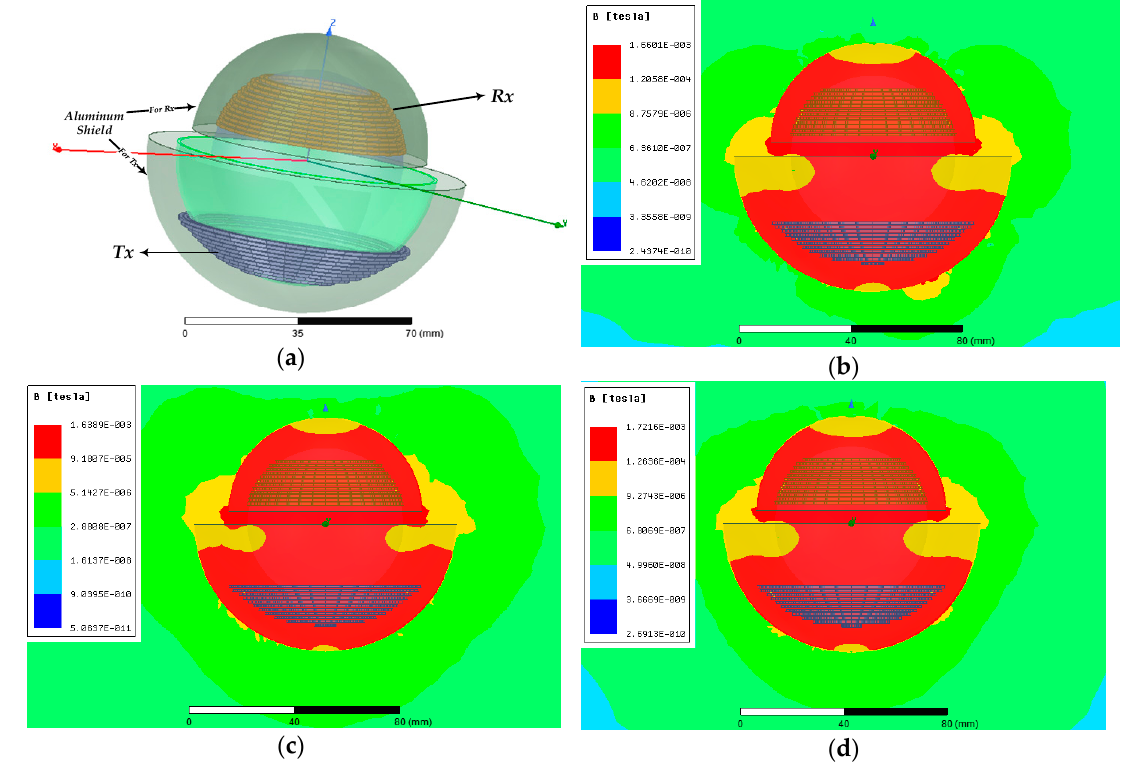
Figure 17. Joint–WPT system: ( a ) aluminum sheet (AL shield) for Tx only; ( b ) 0.3-mm AL shield; ( c ) 1-mm AL shield; ( d ) 2-mm AL shield.